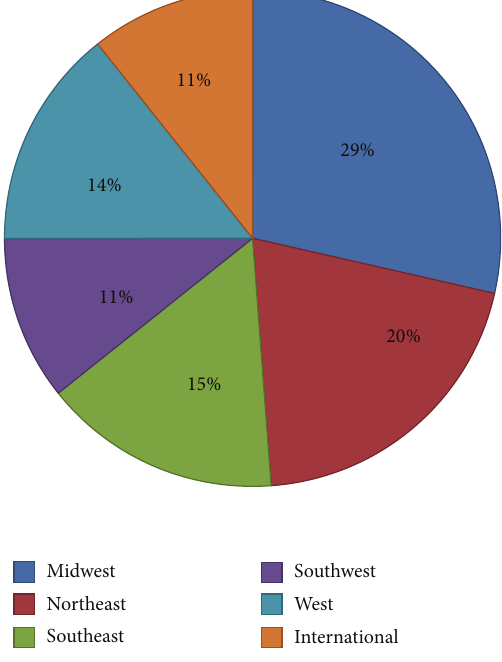
Figure 1: Regions represented by